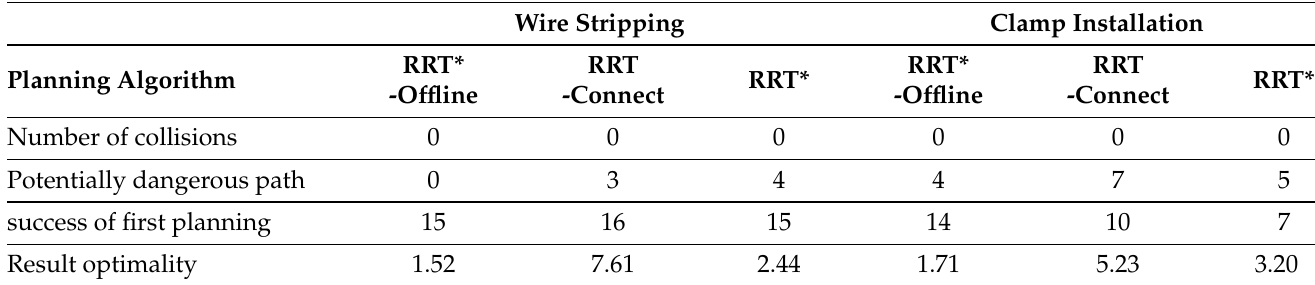
Table 3. Simulation results at the test